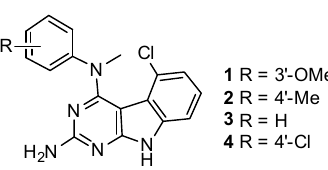
Figure 1. Chemical structures of the Janus compounds 1 – 4 .